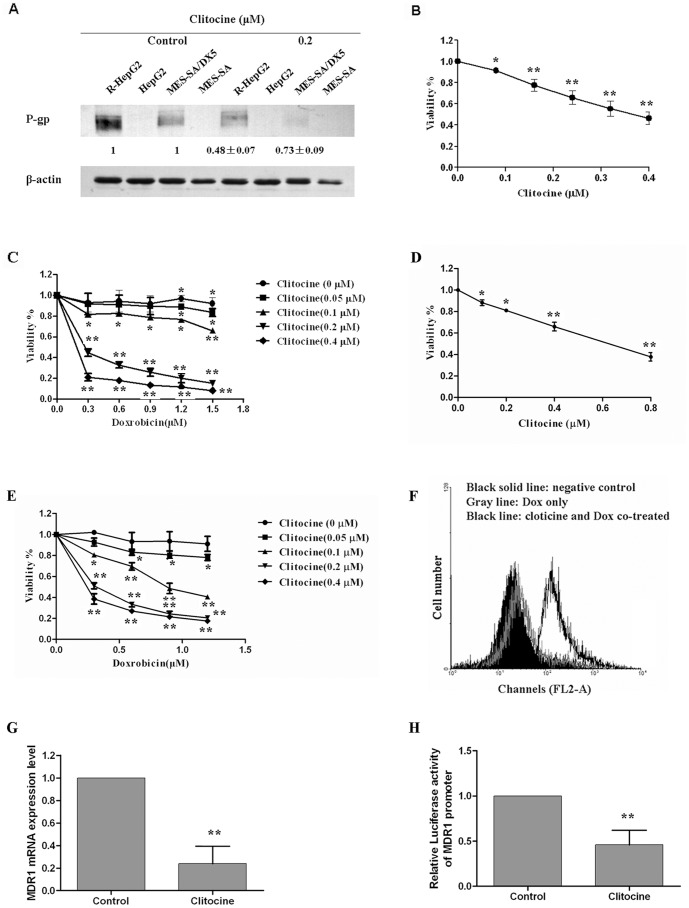
Reversal effect of clitocine in drug resistant cancer cells.(A) P-gp was detected in HepG2, R-HepG2, MES-SA and MES-SA/Dx5 cells by Western blot analysis as described in Materials and Methods. (B) After treatment with different concentrations of clitocine in R-HepG2 cells for 48 h, cell viability was determined by MTT assay. Data are mean ± SD, N = 6. (C) R-HepG2 cells were treated with different concentrations of doxorubicin together with 0, 0.05, 0.1, 0.2 or 0.4 µM clitocine respectively for 48 h. Cell viability was determined by MTT assay. Data are mean ± SD, N = 3. (D) After treatment with different concentrations of clitocine in MES-SA/Dx5 cells for 48 h, cell viability was determined by MTT assay. Data are mean ± SD, N = 3. (E) MES-SA/Dx5 cells were treated with different concentrations of doxorubicin together with 0, 0.05, 0.1, 0.2 or 0.4 µM clitocine respectively for 48 h. Cell viability was determined by MTT assay. Data are mean ± SD, N = 3. (F) Cellular doxorubicin accumulation level in R-HepG2 cells was measured by flow cytometry. The cells were incubated with 2 µM doxorubicin (Dox) alone or together with 0.2 µM clitocine for 24 h. The amount of doxorubicin accumulated in treated cells was quantified by flow cytometric method. (G) MDR1 mRNA level in R-HepG2 cells after clitocine treatment. After treatment with 0.2 µM clitocine for 48 h, total RNA in R-HepG2 cells was extracted. The MDR1 mRNA level in R-HepG2 cells was then measured by qRT-PCR analysis. Data are mean ± SD, N = 6. (H) The relative luciferase activity of full length MDR1 promoter reporter as determined by Dual-Luciferase Reporter Assay System. Cells were transiently transfected with full length MDR1 promoter reporter followed by treatment with 0.2 µM clitocine for 24 h. After that, the cells were lysed and the luciferase activity was measure. Data are mean ± SD, N = 6. *
P<0.05 vs. control, **
P<0.01 vs. control.